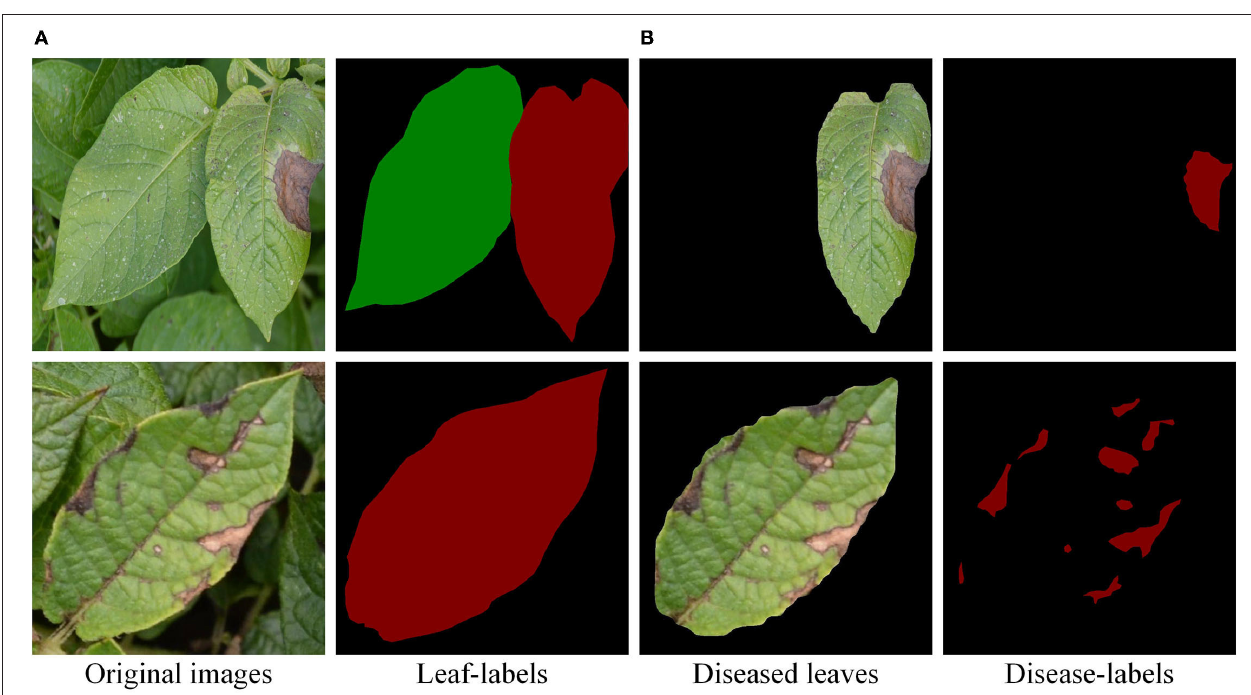
FIGURE 2 | Leaf-labels and disease-labels. (A) The individual leaf separated from the complex background. (B) The leaf scab was